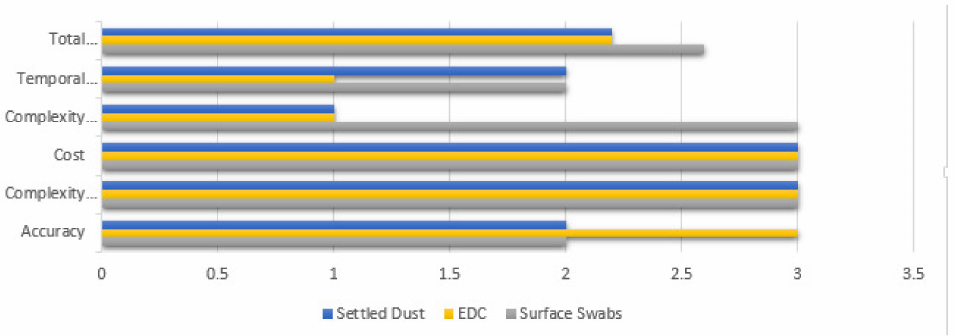
Figure 1. Average scores of the five selected criteria for all studied samples.